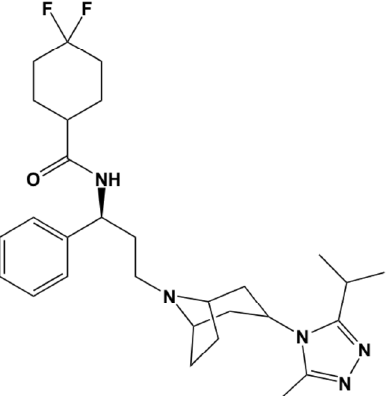
Figure 1. 2D Structure of the known FDA-approved CCR5 antagonist